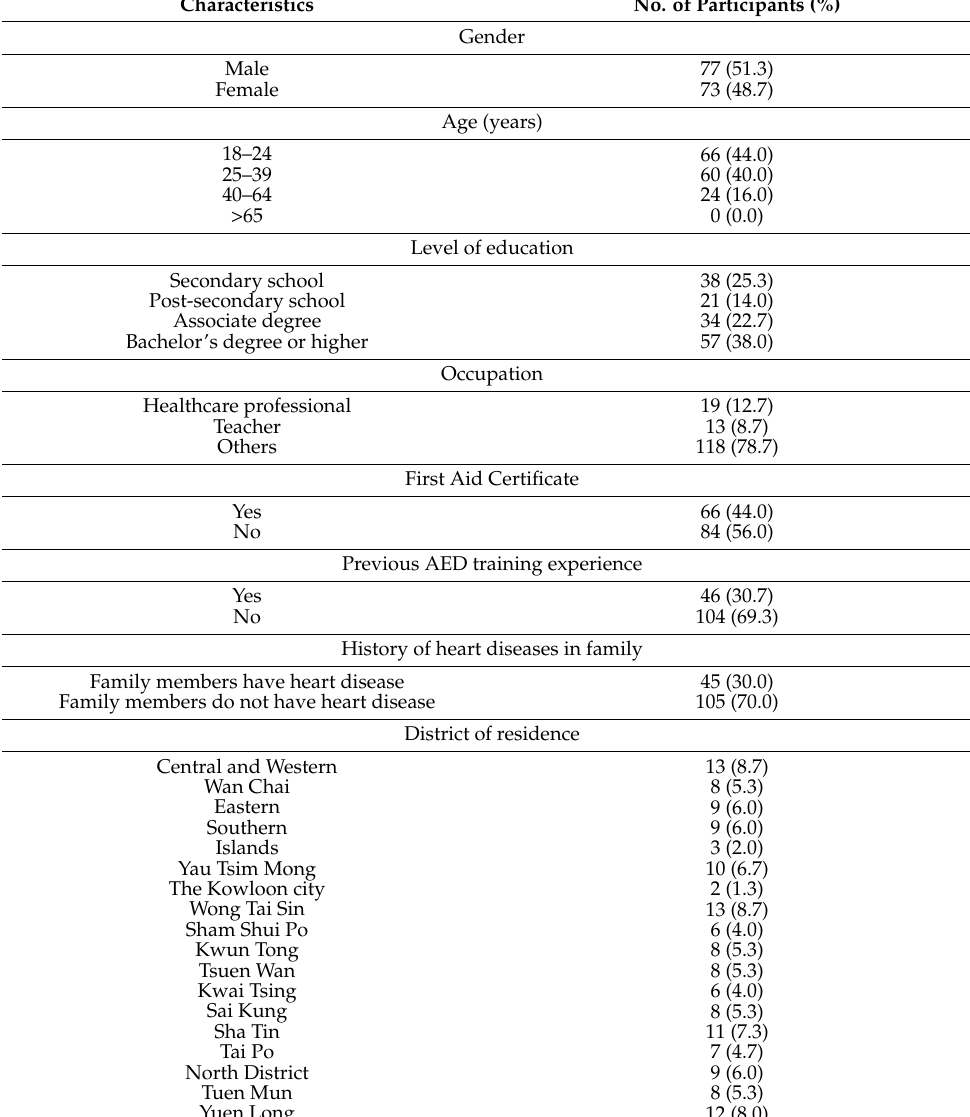
Table 1. Demographic characteristics of the participants (N =